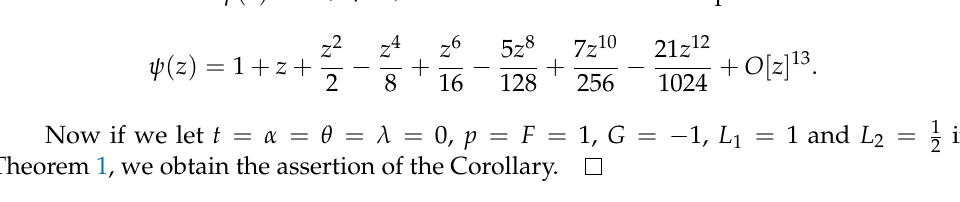
Figure 3. Impact of ℵ ( p ; F , G ; α ; ψ ; z ) on the conic region ψ ( z ) = z + of E under the transformation ψ ( z ) = z +